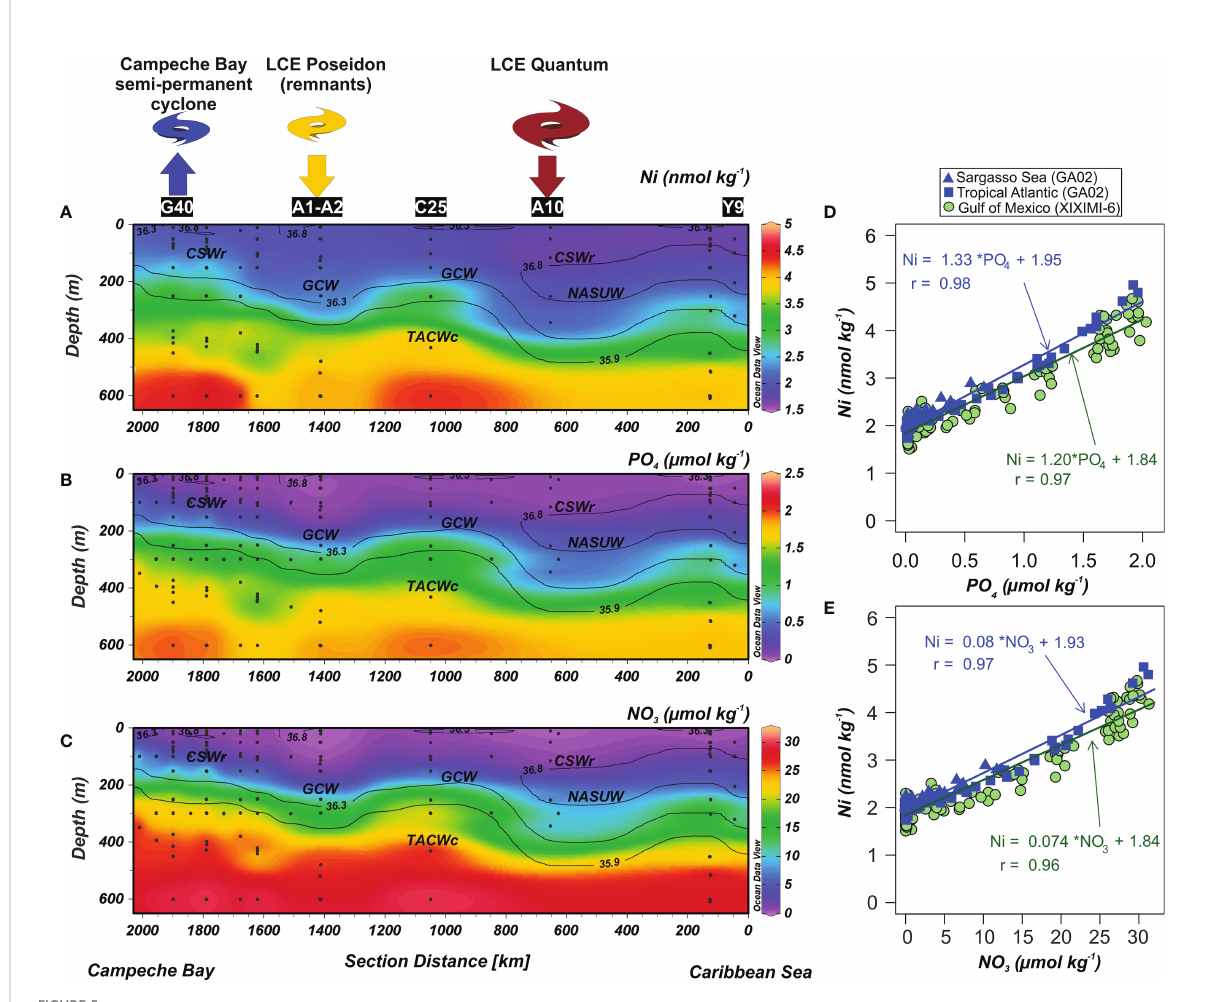
FIGURE 5 Sectional distribution of (A) dissolved Ni, (B) phosphate (PO 4 ) and (C) nitrate plus nitrite (NO 3 ) in the upper 600 m of the water column, along a transect that begins in the Caribbean Sea and ends in the Gulf of Mexico in the Campeche Bay area during the XIXIMI-6 cruise. Dissolved Ni concentration versus (D) PO 4 and (E) NO 3 in the upper 600 m of the water column in the Gulf of Mexico (green dots) compared with those from the North Atlantic (blue symbols) along the GEOTRACES GA02 transect (Schlitzer et al., 2018; Middag et al., 2020). The locations of the sampling stations marked in panel (A) are shown on the map in Figure 4. LCE, Loop Current eddy; CSWr, Caribbean Surface Water remnant; GCW, Gulf Common Water; NASUW, North Atlantic Subtropical Underwater; TACWc, Tropical Atlantic Central Water core; AAIW, Antarctic Intermediate Water; and NADW, North Atlantic Deep